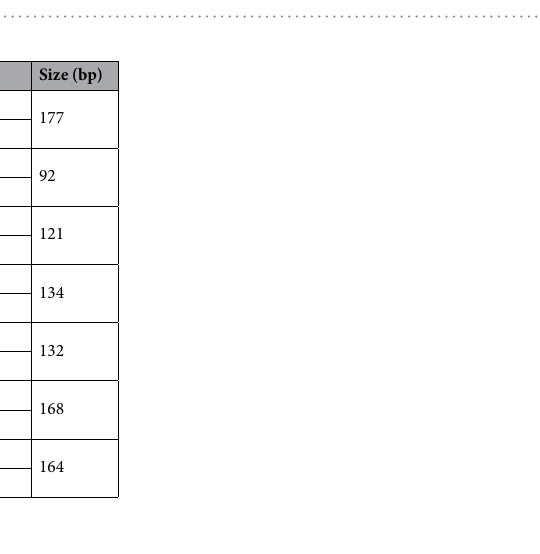
Figure 6. Regulation of DEV UL54 on viral gene translation. DEFs were infected with DEV-LoxP, DEV- Δ UL54 or DEV- Δ UL54 (Revertant) at 400 TCID 50 . After extracting RNC, RT-PCR was performed to assess the relative translational mRNA levels of UL19, UL30, UL48, gC, gD and gK at different time points. * p < 0.05; ** p < 0.01.